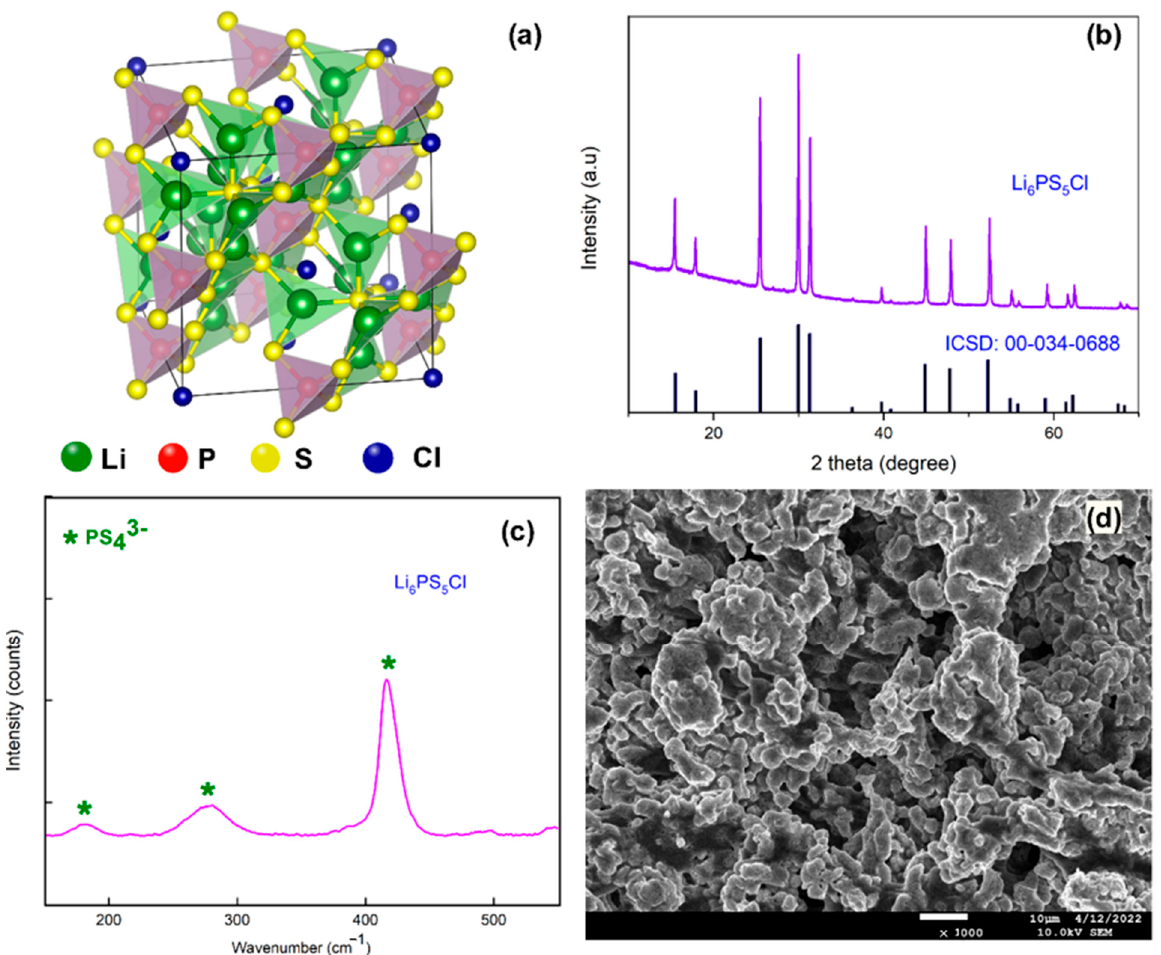
Figure 1. ( a ) The crystal structure, ( b ) powder X-ray di ff raction pa tt ern, ( c ) laser Raman spectrum, and ( d ) FE-SEM image of the Li 6 PS 5 Cl solid electrolyte.